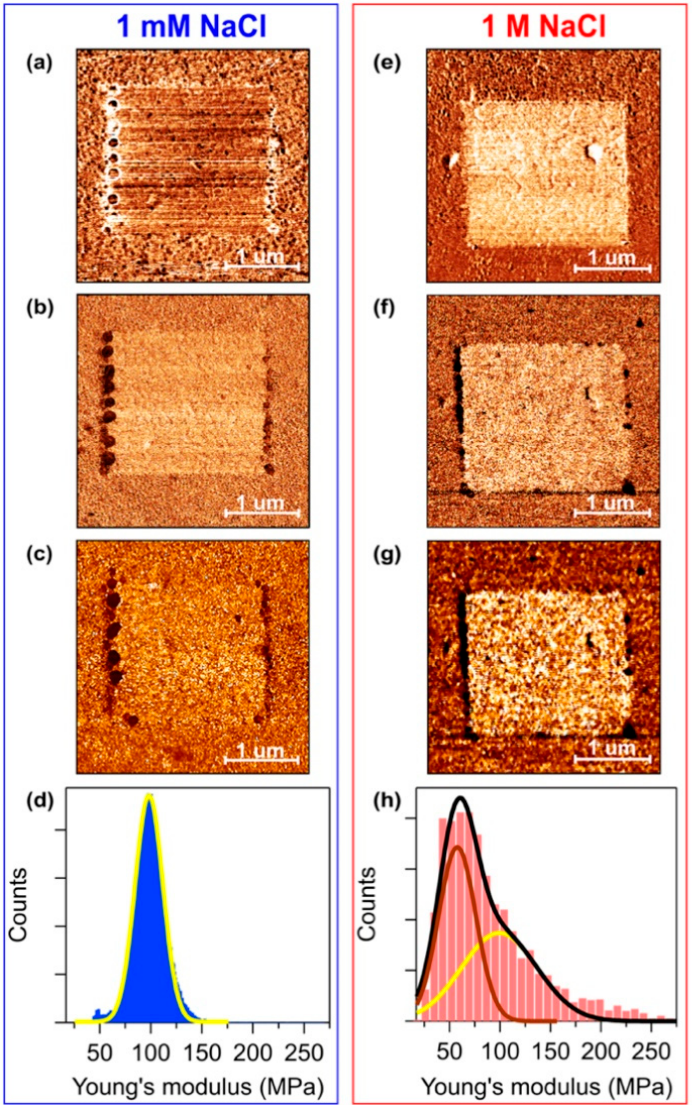
Figure 2. Shaving experiment on C 6 -ssDNA SAMs prepared in ( a–d ) 1 mM NaCl and ( e–h ) 1 M NaCl buffer. ( a,e ) Lateral deflection images acquired in contact mode (data scale: 20 mV). ( b,f ) Slope images acquired in QI mode (data scale: 250 N/m). ( c,g ) Young’s modulus images obtained from QI force curves (data scale: 150 MPa) and ( d,h ) related histograms.